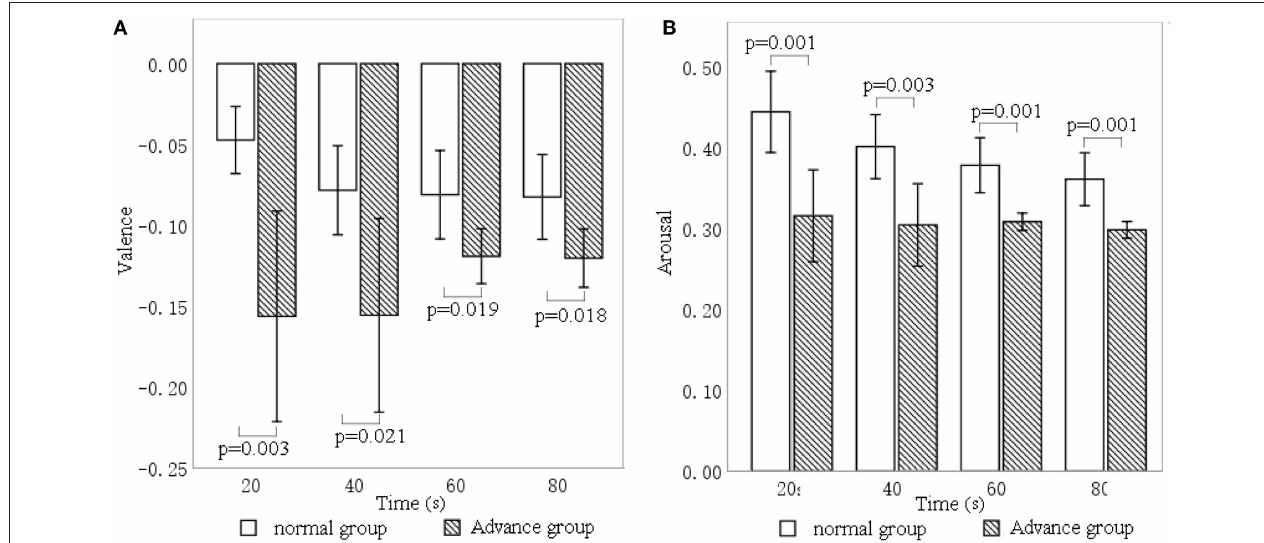
FIGURE 9 | Differences in (A) valence and (B) arousal for music intervention of different durations.